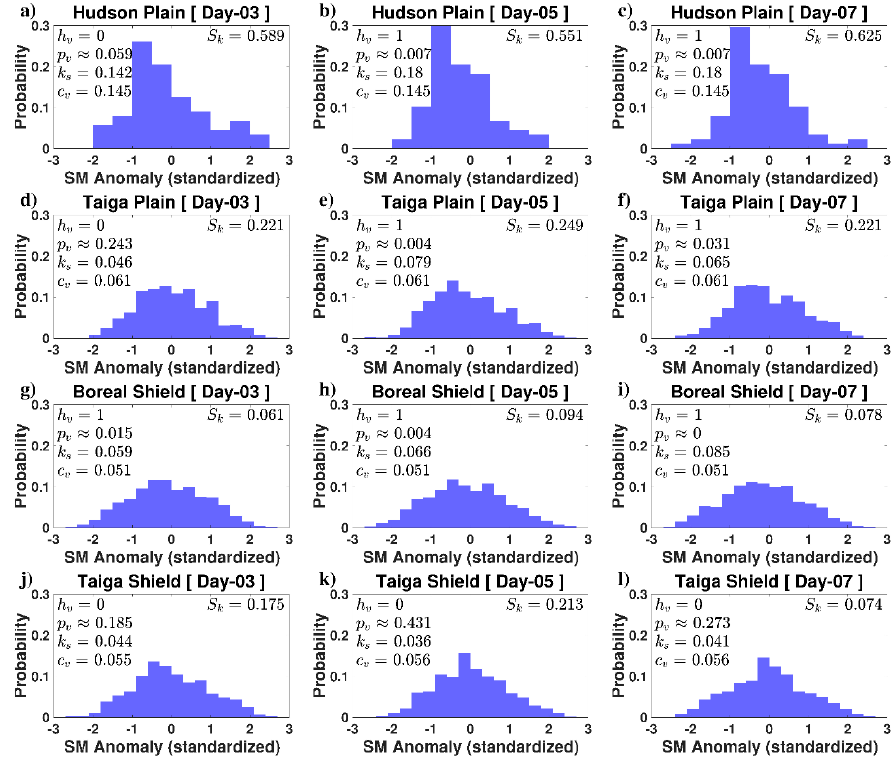
Figure 5. Distributions of fires with burned area greater than 200 ha. Soil moisture anomaly distributions at 3-days, 5-days, and 7-days (column-wise, left to right) prior to the occurrence of fire for ecozones Hudson Plain ( a – c ), Taiga Plain ( d – f ), Boreal Shield ( g – i ), and Taiga Shield ( j – l ), respectively. The parameters h, p, ks, and cv are MATLAB Kolmogorov-Smirnov (KS) test result parameters, as in Figure 4. The parameter Sk (top right) indicates the skewness of the distribution.